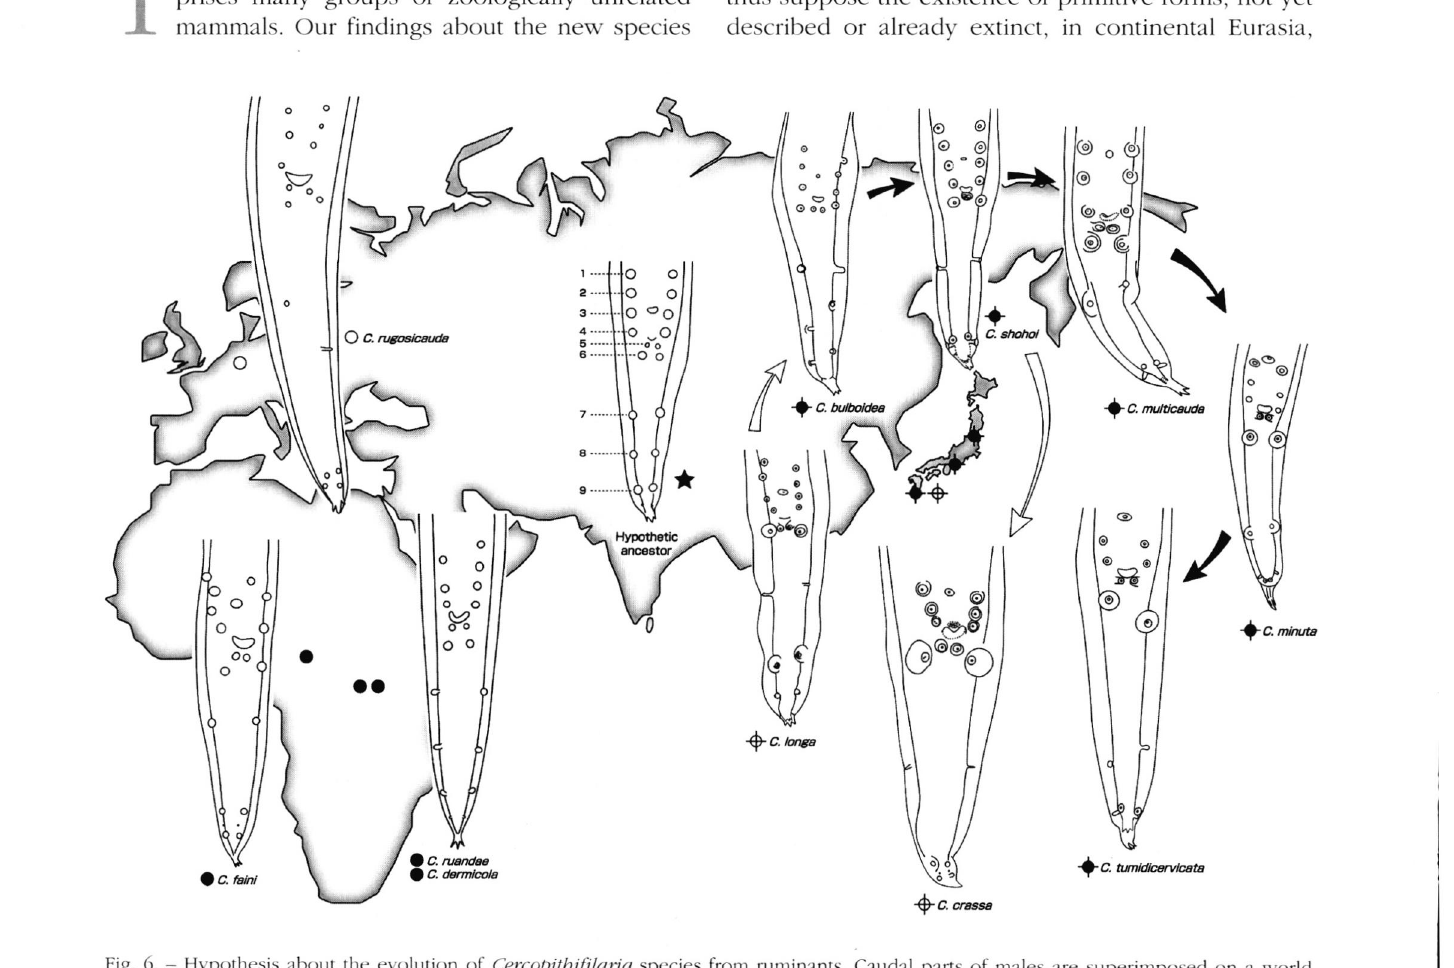
Fig. 6. - Hypothesis about the evolution of Cercopithifilaria species from ruminants. Caudal parts of males are superimposed on a world map. Bold arrows: successive speciations in Capricornus crispus. Open arrows: two speciations by captures, the first (shorter arrow) from sika to serow, and the second in the opposite direction. Star, hypothetic ancestor. Bold circles, bovids; open circles, cervids. Symbols for organisms found in Japan are marked with a plus